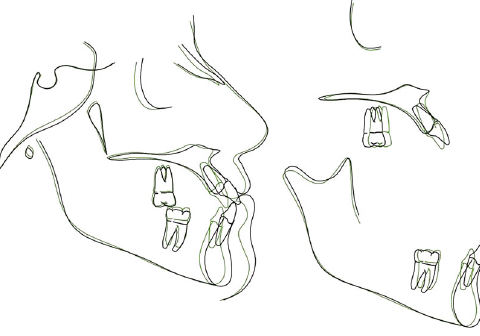
Figure 9: Pretreatment and posttreatment tracing superimposition.